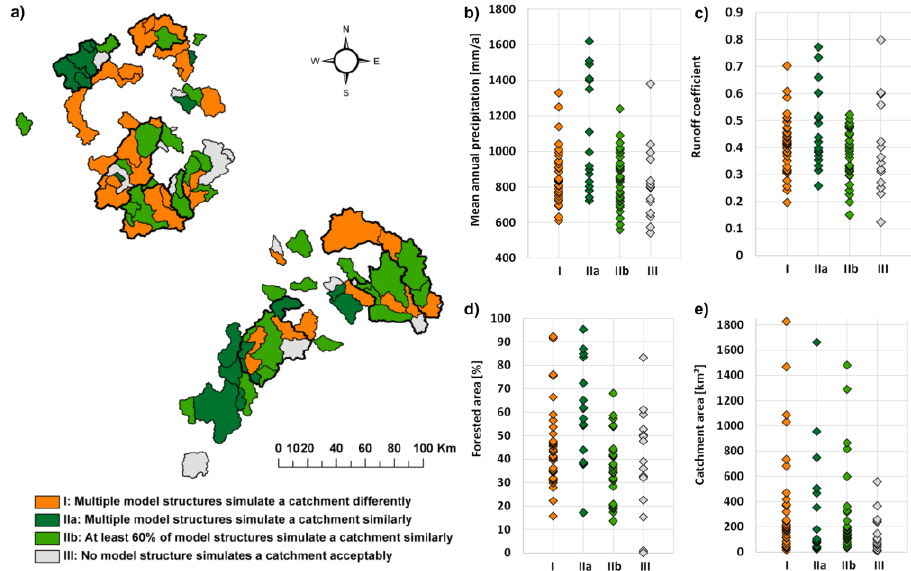
Figure 7. Spatial distribution of catchments with similar or different patterns of signature indices ( a ). Borders of large catchments with several upstream catchments are marked with a bold line. Please note, nested catchments are sorted by size: only the headwater catchments are displayed completely. ( b – e ) display catchment properties of catchments in categories I to III.